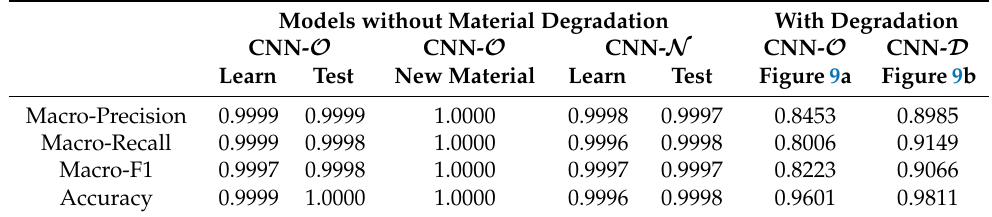
Table 5. Statistical measures describing the accuracy of vibration mode shapes